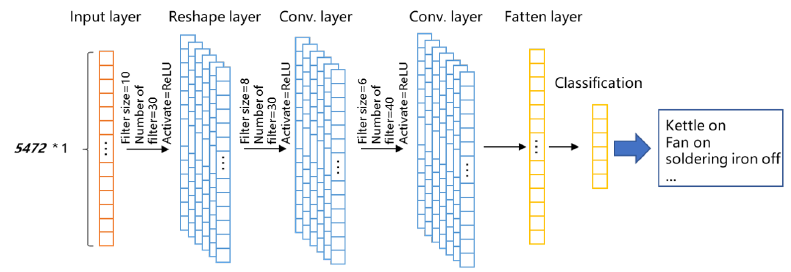
Figure 9. The model construction of the neural